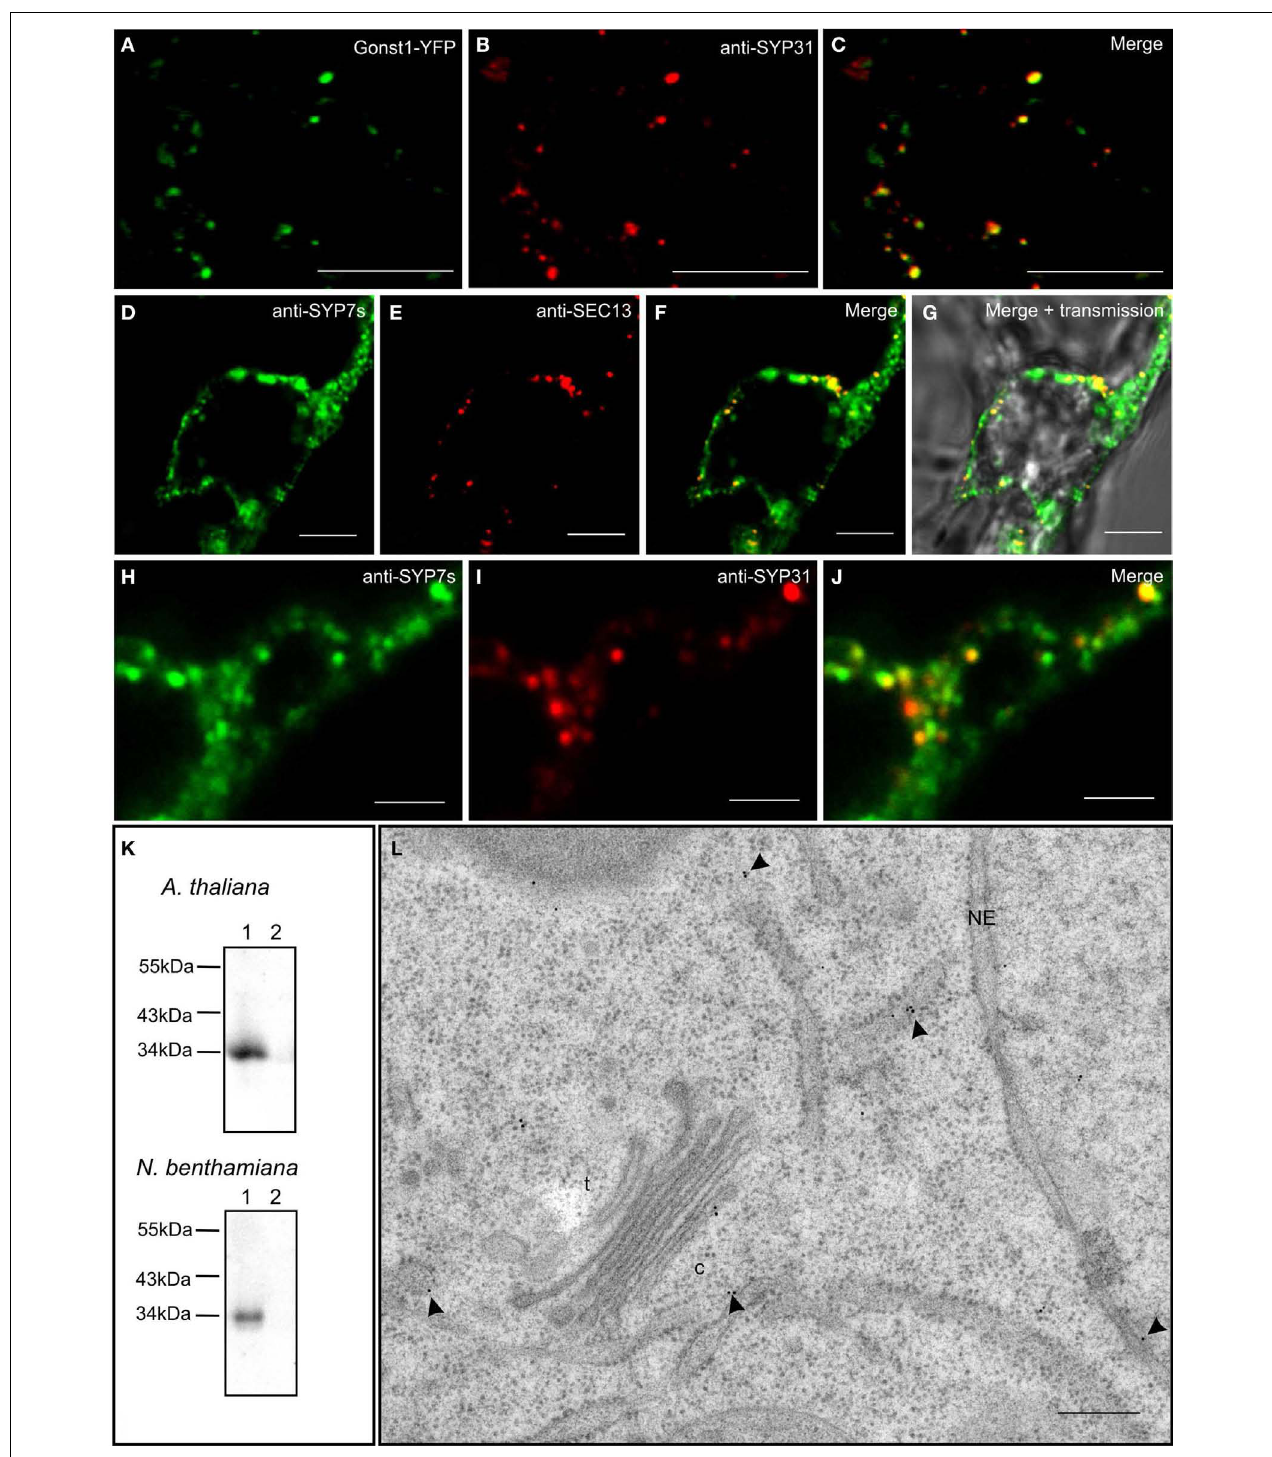
antiserum in total membrane preparations (lanes 1) from Arabidopsis and tobacco leaves (lane 2 is the 100,000- g supernatant as a negative control). (L) Immunogold labeling with SYP7 antibodies of a thin section cut from a high pressure frozen Arabidopsi s root tip. Arrowheads point to gold particles. c , cis -Golgi; t , trans -Golgi; NE, nuclear envelope. Magnification bars = 5 µ m (A–G) ; 1 µ m (H–J) ; 300nm (L)